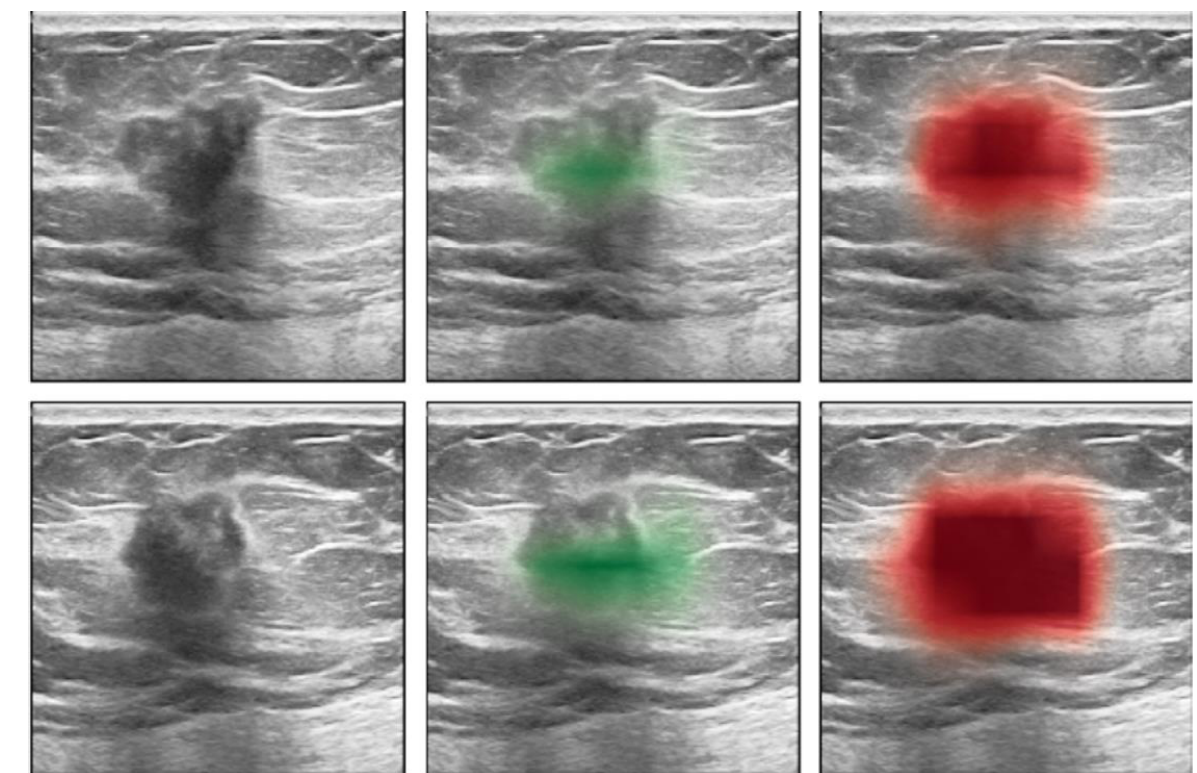
Figure 10. From Shen et al. [157] Case B from their Figure 3. No changes have been made. https://creativecommons.org/licenses/by/4.0/legalcode (accessed 12 March 2022). Sagittal ( top row ) and transverse views ( lower row ) of a biopsy proven-cancer. The images on the ( left) are the B-mode images. The saliency maps indicate the predicted locations of benign ( middle ) and malignant ( right ) findings.